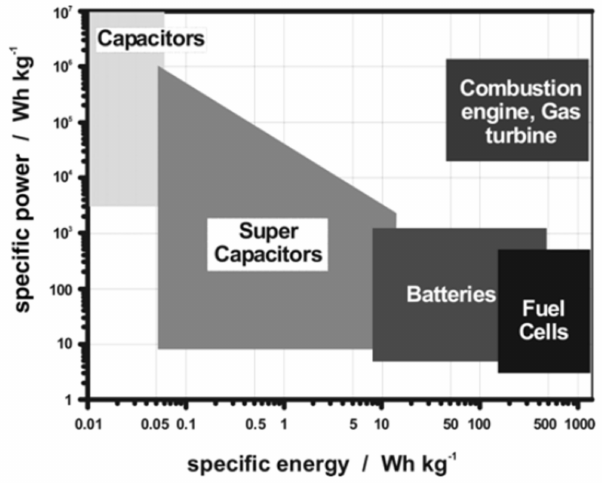
Figure 2. Ragone plot of different electrochemical energy conversion systems, combustion engines, turbines, and traditional capacitors [48]. [Reprinted with permission from Ref. [48] Copyright {2004} American Chemical Society.]